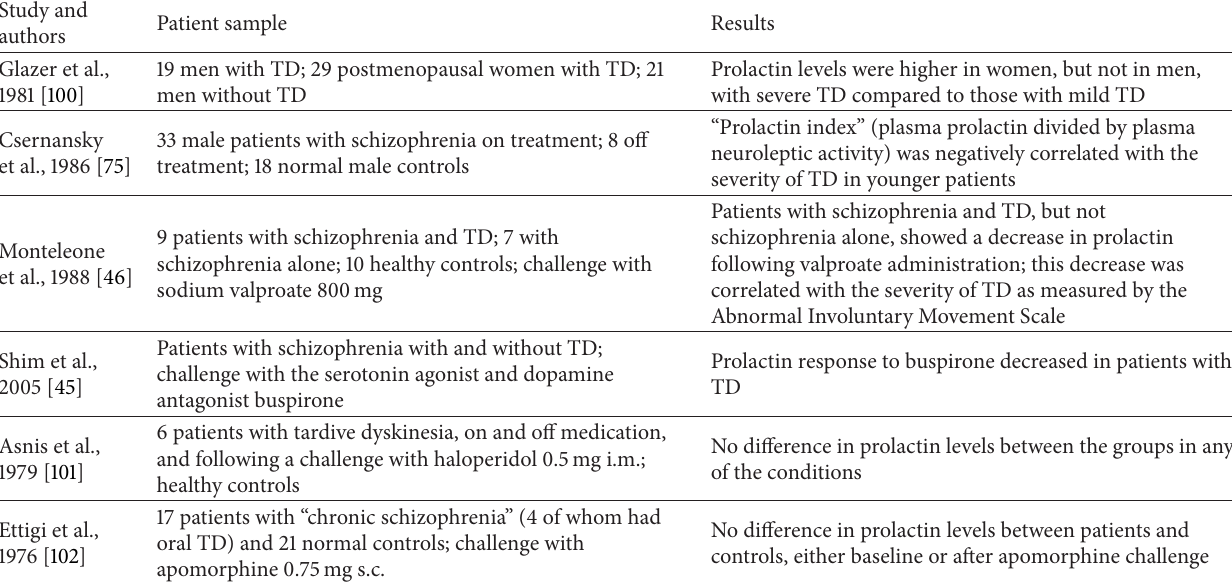
Table 5: Studies examining the relationship between prolactin and tardive